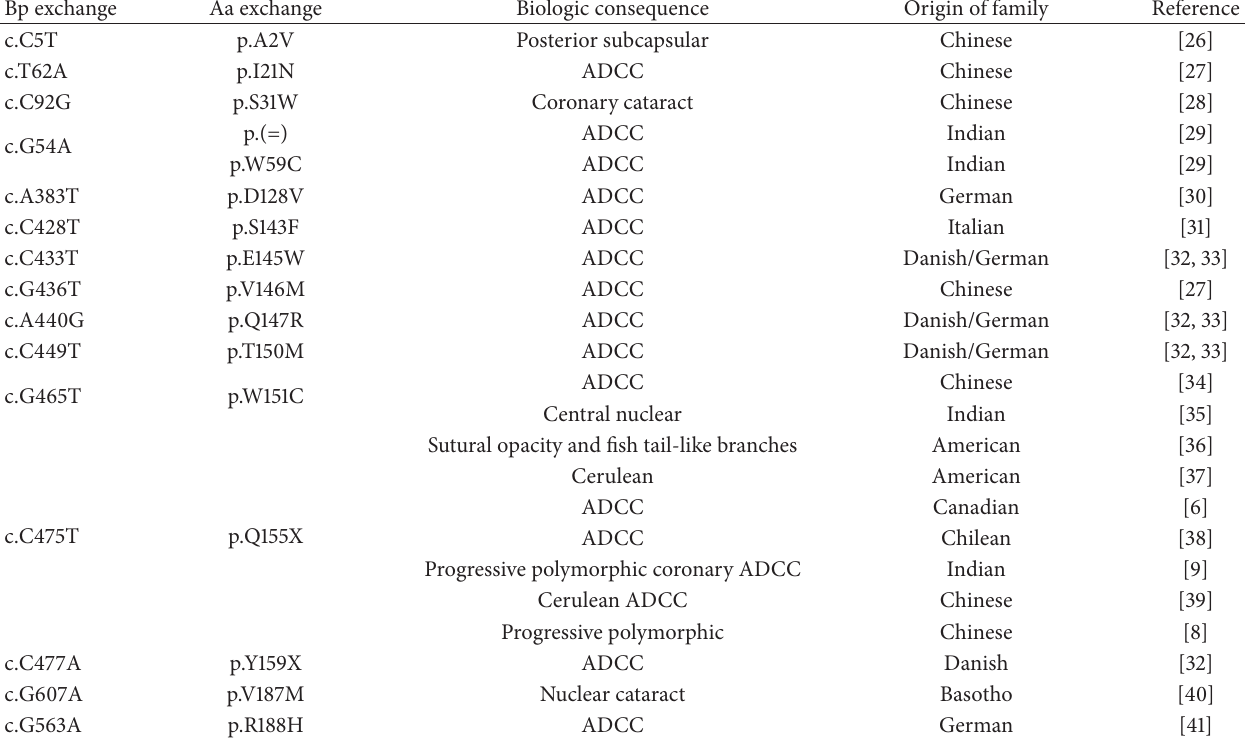
Table 3: Mutations previously described in the CRYBB2 gene associated with congenital cataracts in